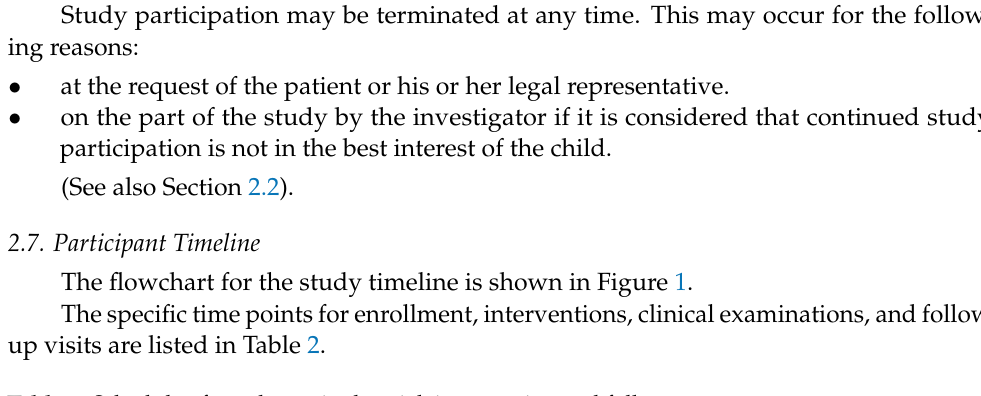
Table 2. Schedule of enrolment in the trial, intervention and follow